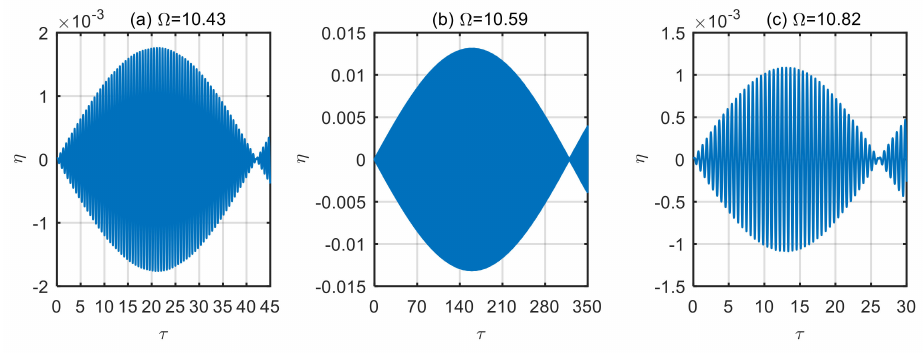
Figure 10. Displacement time history diagram of microtubes with different dimensionless frequencies of excitation loads ( u = 4). ( a ) Ω = 10.43; ( b ) Ω = 10.59; ( c ) Ω = 10.82.